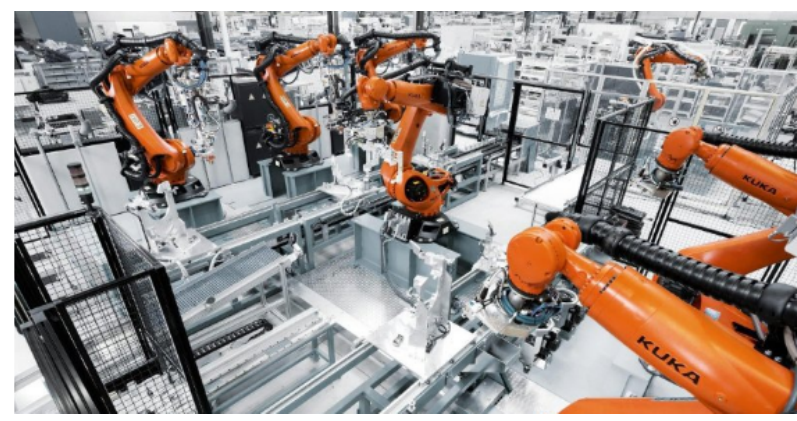
Fig. 8 – Robots (illustration extracted from [ 10 ]) Swarms of robots (networks, connected via combination of cloud, fog, mist) are likely to generate massive amounts of data. This data, if acquired, analyzed, and used in feedback control, may optimize process, reduce waste and compress production time. Use of “intelligent” decision systems platforms, various levels of automation, and predictive analytics, may transform the concept of ‘zero’ downtime to manufacturing reality, more or